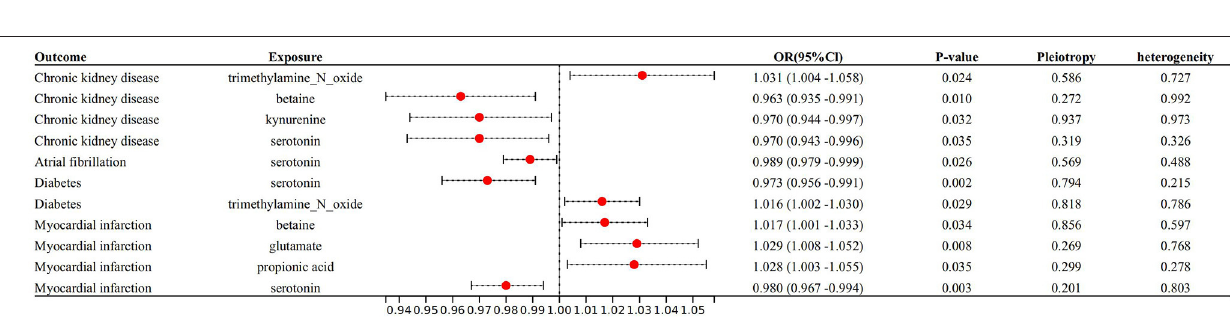
FIGURE 6 | Forest plot to visualize the causal effect of Gut metabolites on the risk of heart failure risk factors by invers variance weighted